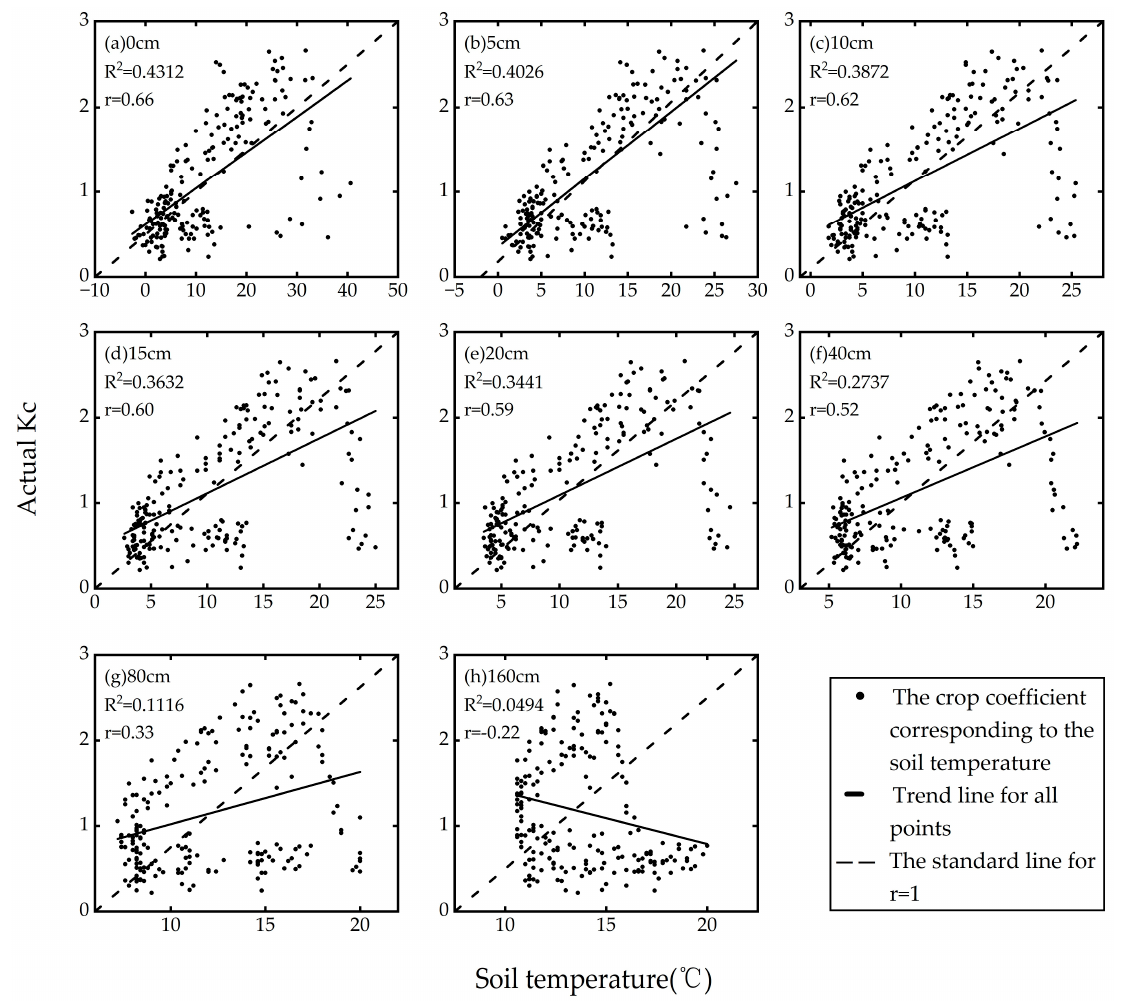
Figure 4. Correlation between crop coefficient and soil temperature from 0 to 160 cm(a to h in the figure represent the deepening of soil depth).